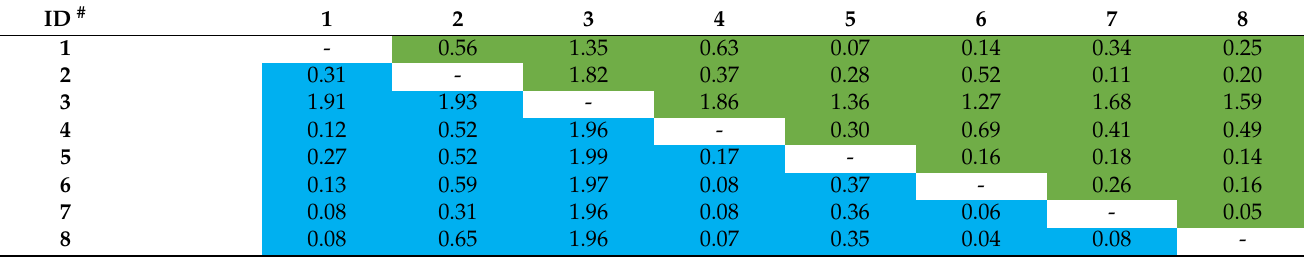
Table 4. JM * distance values of each LC class used in this research calculated for S1 (blue color) and S2 (green color) sensors. ID #